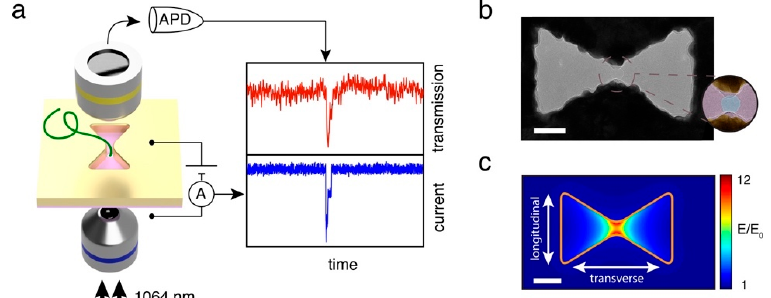
permission © 2018 American Chemical